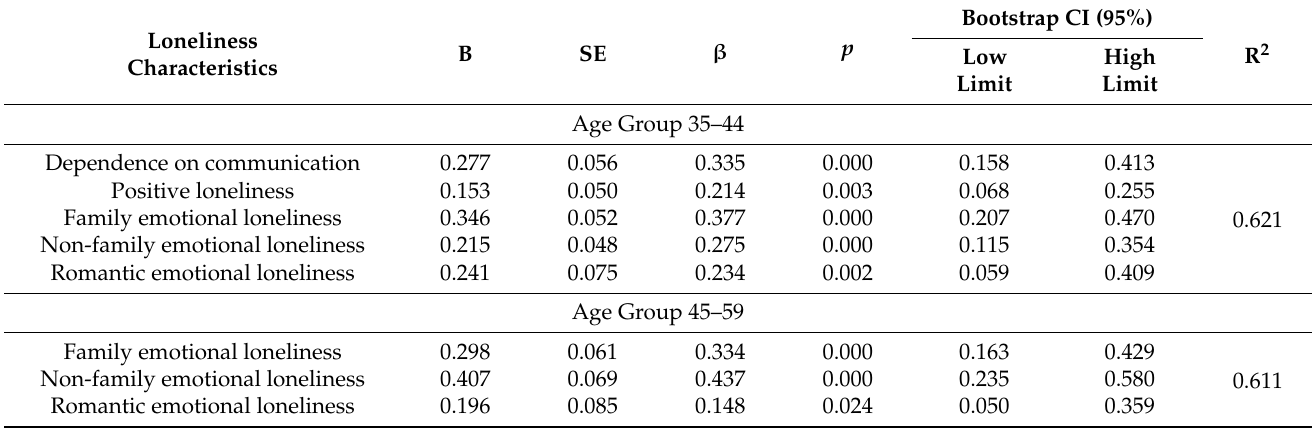
Table 3. Regression analysis of loneliness variables in age groups in pre-pandemic sample.